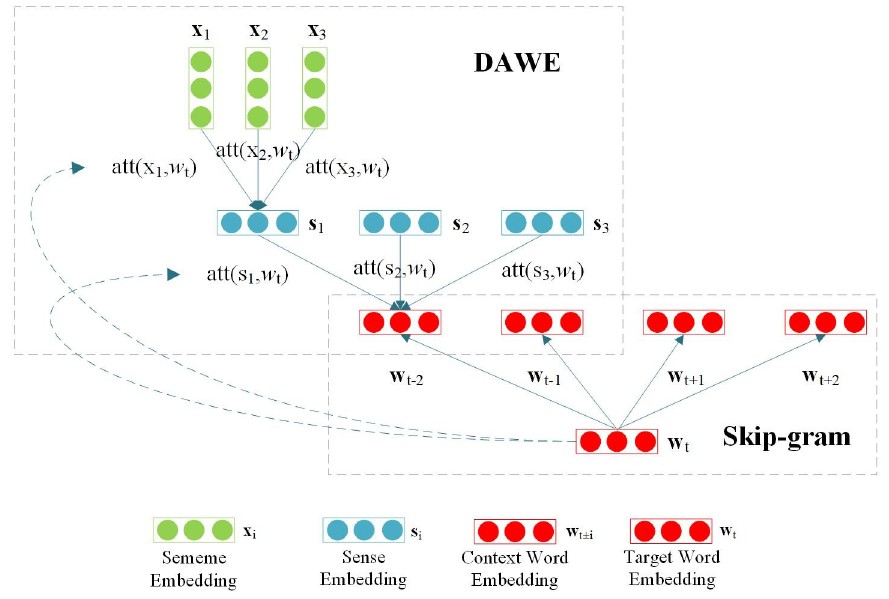
Appl. Sci. 2020 , 10 , x FOR PEER REVIEW Figure 6. Double attention over context model (DAC). Figure 6. Double attention over context model (DAC).